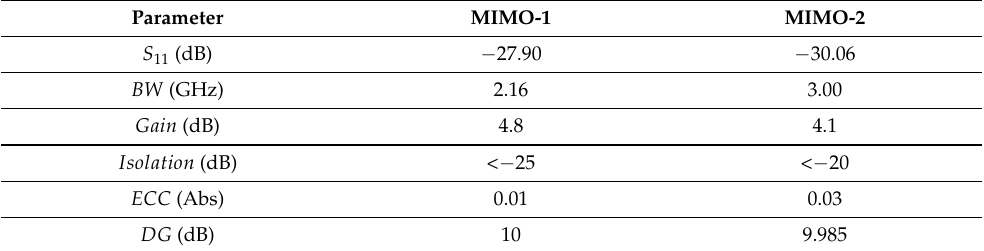
Table 2. Performance comparison of MIMO-1 and MIMO-2 for d = 0.54 λ 0 , 28